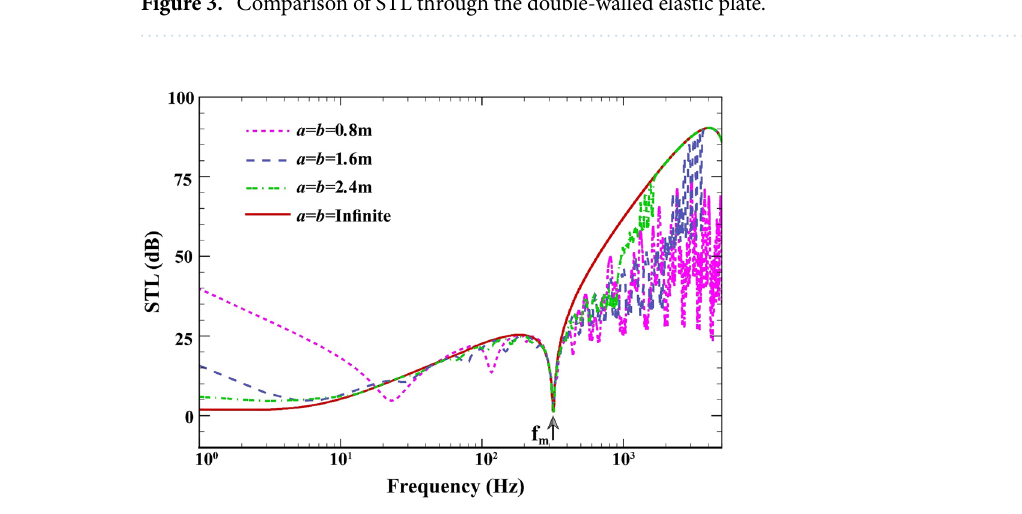
Figure 4. STL of double-walled sandwich composite MEE plate against plate dimensions.